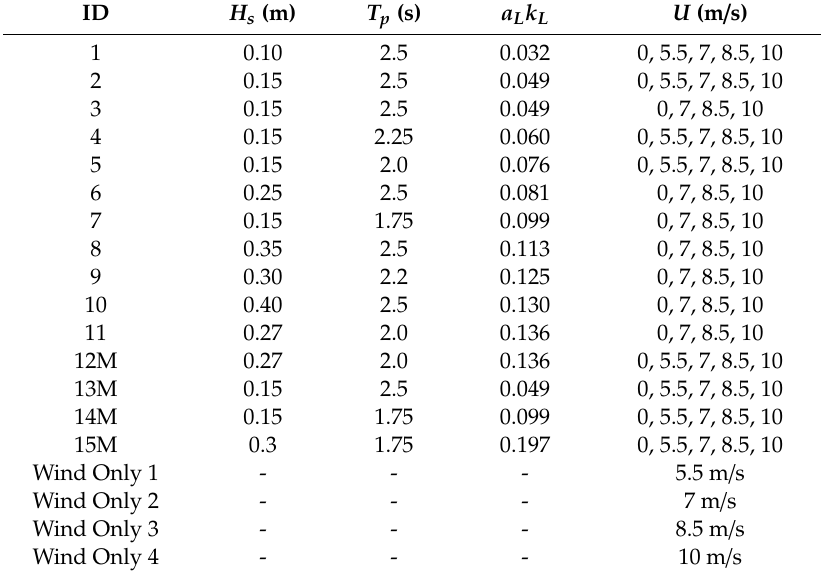
Table 1. Wave parameters used to characterize the JONSWAP for the wave